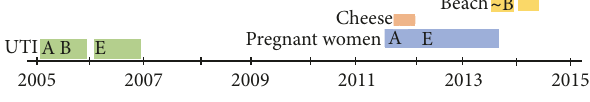
Figure 1: Distribution of isolates obtained from different sources in Rio de Janeiro according to time. Capital letters represent the urinary tract infection (UTI) PFGE types. “ ∼ B”: beach isolate with 82% similarity with UTI type